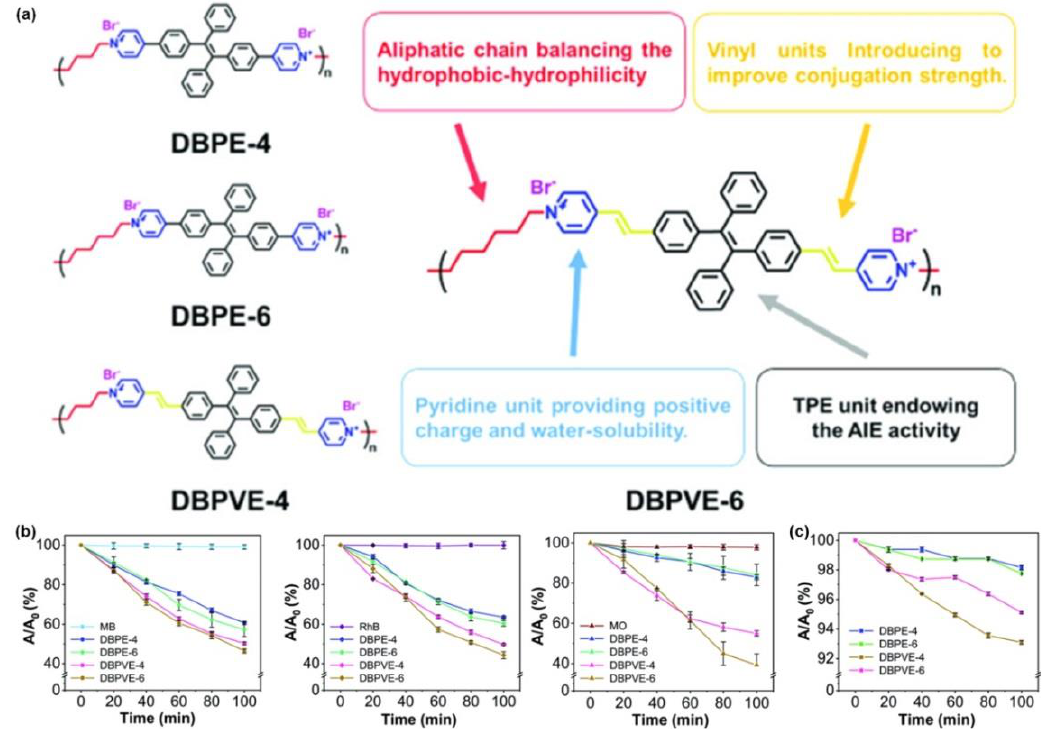
Figure 14. ( a ) The chemical structures of DBPE-4, DBPE-6, DBPVE-4 and DBPVE-6. ( b ) Decompo- sition ratio of MB, RhB and MO upon mixing with DBPE-4, DBPE-6, DBPVE-4 and DBPVE-6 un- der white light irradiation, respectively. ( c ) The self-decomposition rates of the four polymers un- der white light irradiation. Reprinted with the permission from Ref. [60]. 2021, Royal Society of